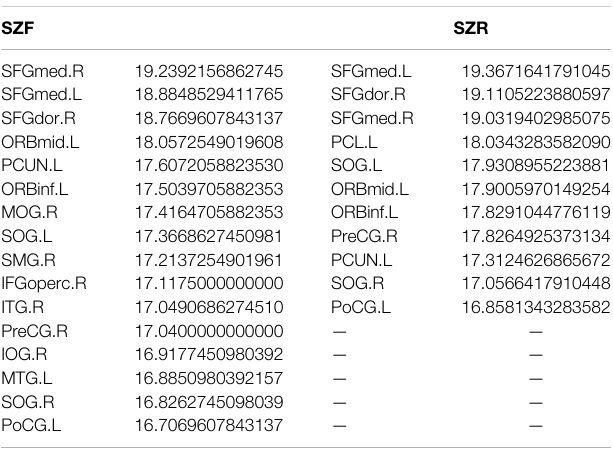
TABLE 4 | Degree hubs in the SZR and SZF groups. SZF SZR